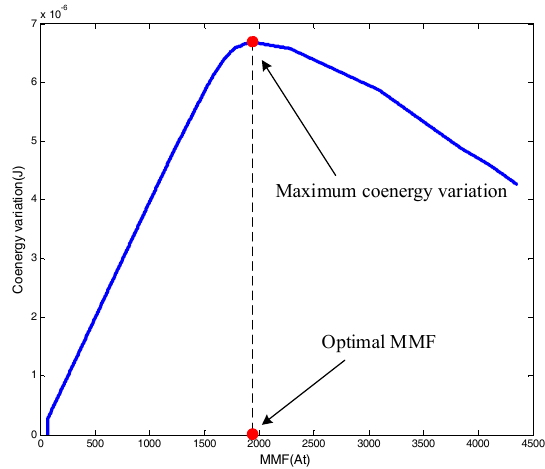
Figure 17. Flux linkages corresponding to MMF of aligned and unaligned positions.